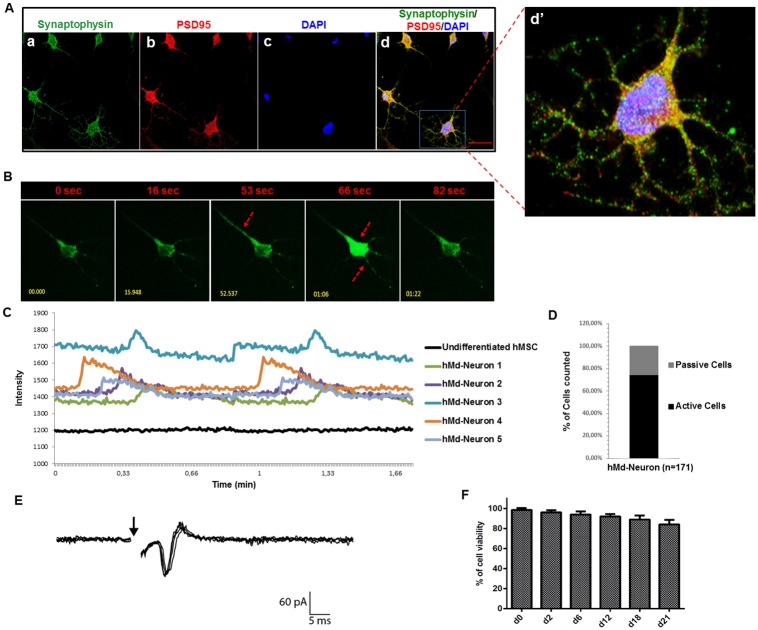
Donor derived hMd-Neurons mature into functional neurons with both spontaneous and electrophysiological activity Confocal images of neuronal induced hMSCs from healthy bone marrow donors (2–10 aged) at day 12 reveals the expression of synaptic proteins (a) Synaptophysin and (b) PSD-95 with (c) DAPI nuclear stainings. Merged image represents positive co-staining of Synaptophysin and PSD-95 for each individual hMd-Neurons (d). Dashed yellow squares magnified 5 folds (d’). Functionality of hMd-Neurons was evaluated using Fluo-4 calcium indicator for real time Ca++ ion imaging without any stimulatory chemical addition. (B) Florescent images (e-i) represents real time firing patterns of hMd-Neurons from hMSCs via imaging of Ca++ signal transmission through a single neuron and arrows indicate initiation and termination of firing in seconds (sec). (S3 Fig and S2 Video). (C) Representative histogram indicates firing frequency of each individual hMd-Neurons as twice in less than 1 minute. No signs of activity of uninduced hMSCs of the same donors were detected. (D) Upon imaging Ca++ ion dynamics, 74,6% of cells were counted as spontaneously active according to firing situation (percentages were determined from average of 3 different donors). (E) Represantative patch clamp (whole cell) recordings of donor derived hMd-Neurons upon 18 days neuronal induction. (F) Prior to electrophysiology experiments, long term hMd-Neurons viability was evaluated for further maturation in culture using Cell Titer Glo (Promega) assay. Data are represented as mean ± S.E.M. Scale bars represent 50 μm.